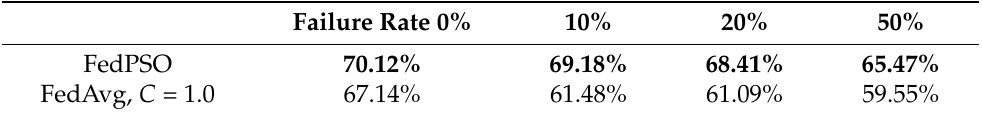
Table 5. Difference in accuracy according to the probability of communication